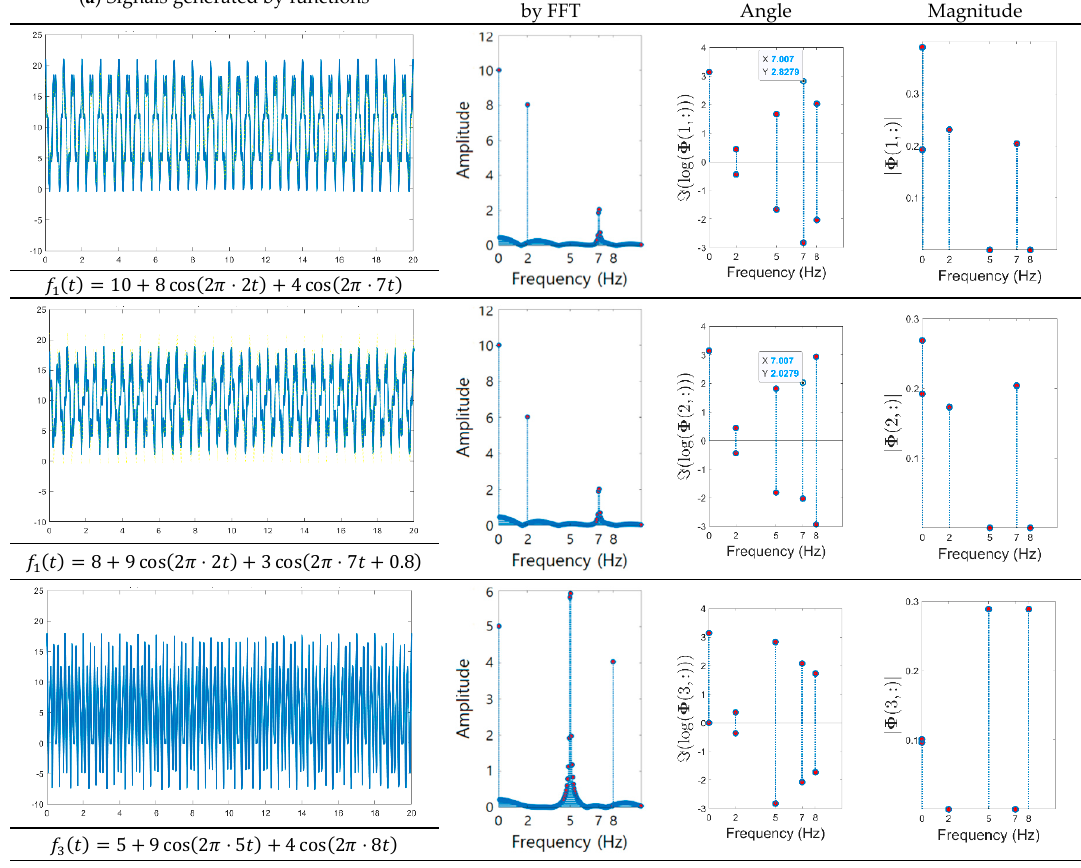
Figure 2. Comparison of analysis of the signals from three specific channels by FFT and by DMD. ( a ) The shape of the signals and the functions defined for the signals. The first and second signals are derived with the same eigenfunction, and there is a phase di ff erence of 0.8 for the second eigenfunction with period 7. ( b ) Power spectrum graphs by calculating each channel by fast Fourier transformation. Phase transition for channels 1 and 2 cannot be determined. ( c ) Graphs of mode values calculated by dynamic mode decomposition on the